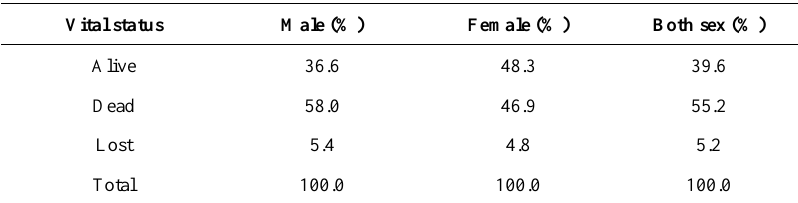
Table 1. Vital status of workers in MWC by sex as of December, 31, 2016